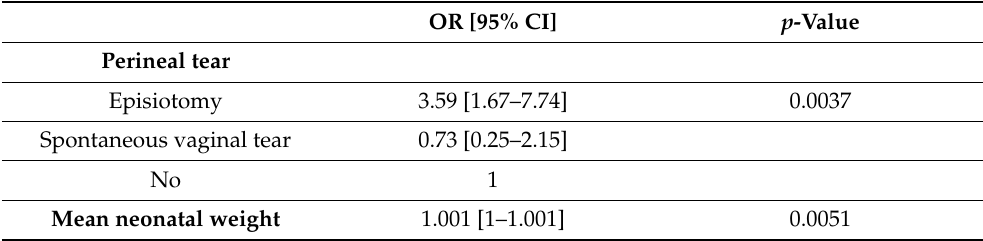
Table 3. Logistic multivariable model using the presence of postpartum hemorrhage (PPH) as outcome. Odds ratios (OR) and 95% confidence intervals are reported both with the p -value of models.